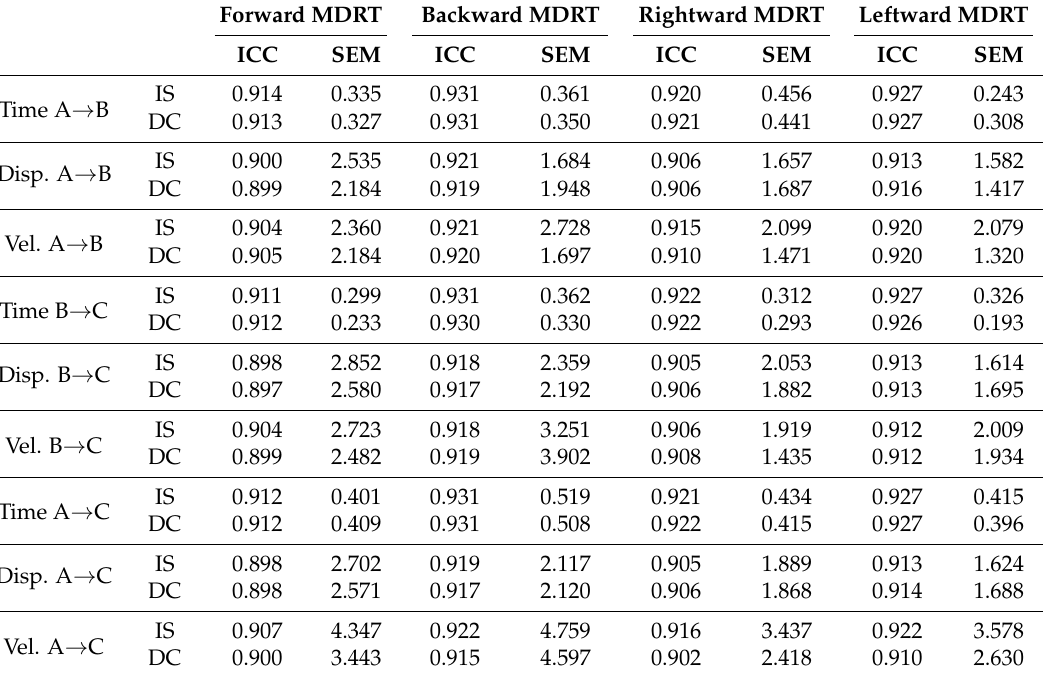
Table 1. Reliability of the measure for all variants of MDRT.